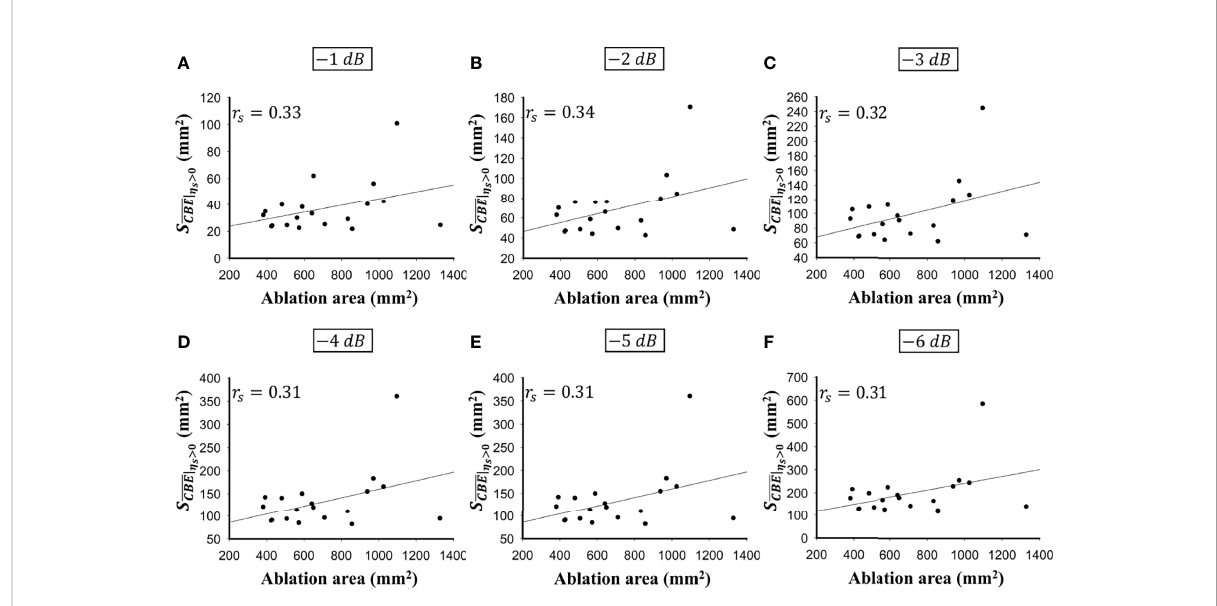
FIGURE 7 The relationship between the ablation zone size and S CBE j obtained according to various contour criteria. (A) − 1 dB; (B) − 2 dB; (C) − 3 dB; (D) h s> 0 − 4 dB; (E) − 5 dB; (F) − 6 dB. The correlation r S s between CBE j h s> 0 and the ablation zone size were approximately 0.3 for each contour criterion, which indicates that S CBE j is not able to characterize the ablation h s> 0